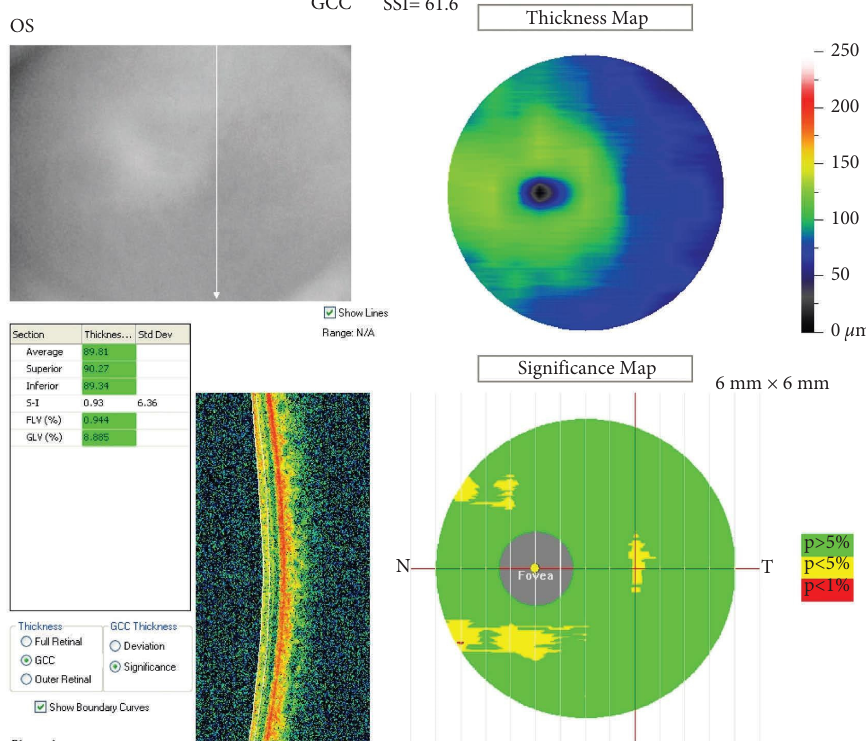
Figure 4: Normal GCC measurement and OCT image of a patient from the patient